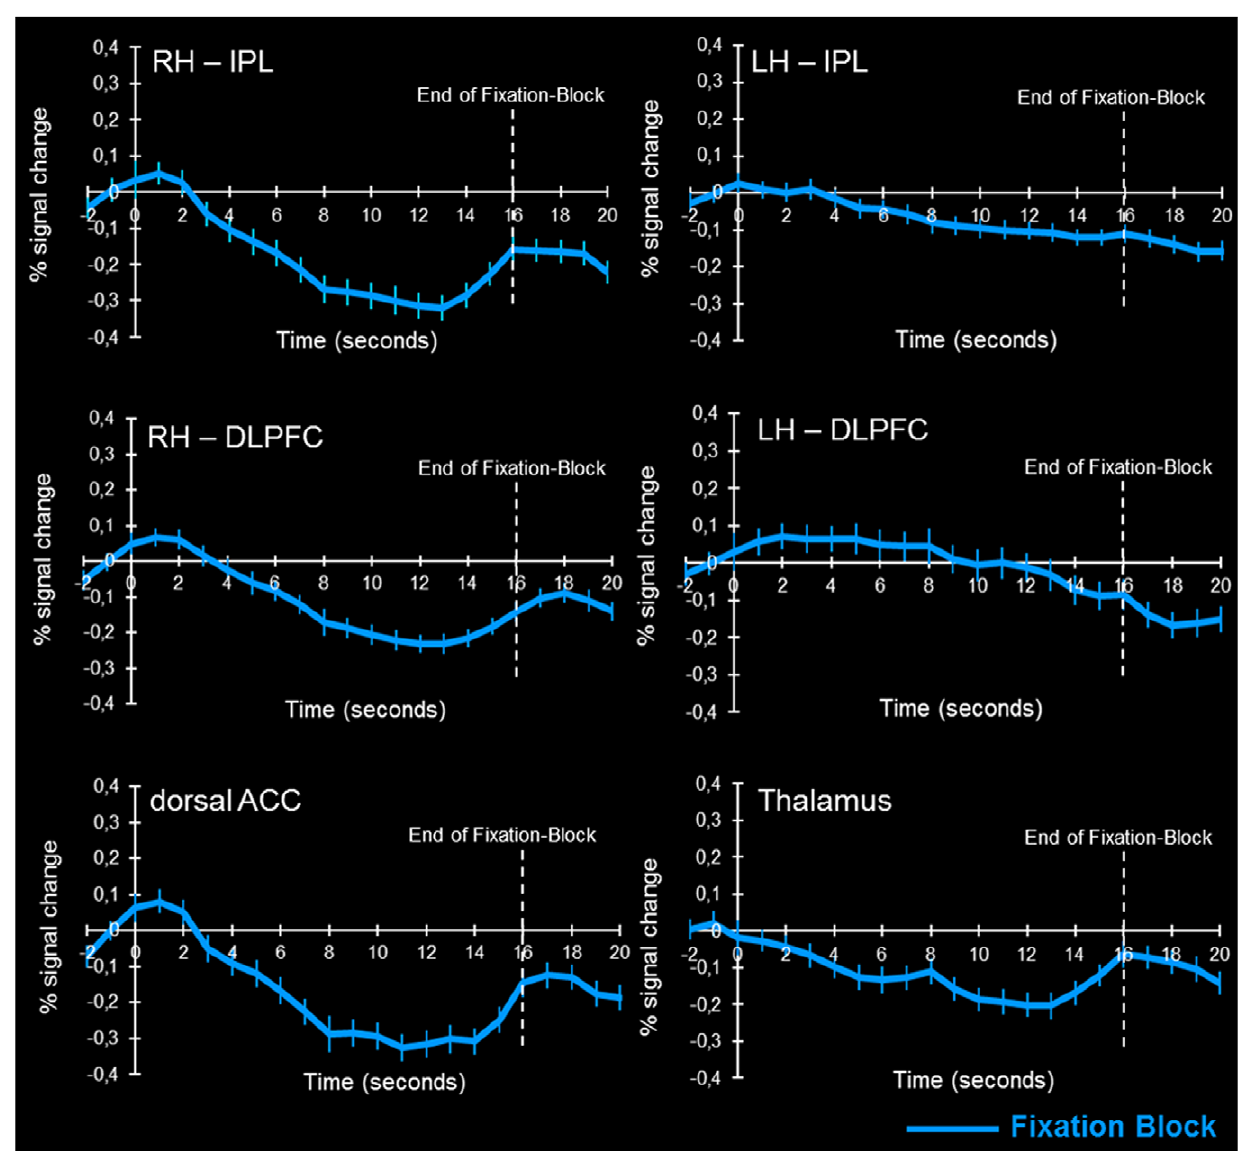
Figure 8. Averaged time course plots of the BOLD response during the low-level baseline condition (fixation). For several clusters of interest, averaged time course plots illustrate the evolution of the BOLD response, averaged across all 16 participants, during the fixation block (blue line). Relative to the last 3 time points (4.8 s) of the intrinsic alertness task, the averaged time course plots depict the amount of signal change for the complete duration (16 s) of the fixation block. Error bars represent the SEM, averaged across all participants, and the dashed white line marks the end of the fixation block. Time zero always corresponds to the beginning of the fixation block. (ACC=anterior cingulate cortex; DLPFC=dorsolateral prefrontal cortex; IPL=inferior parietal lobule; RH=right hemisphere; LH=left hemisphere)